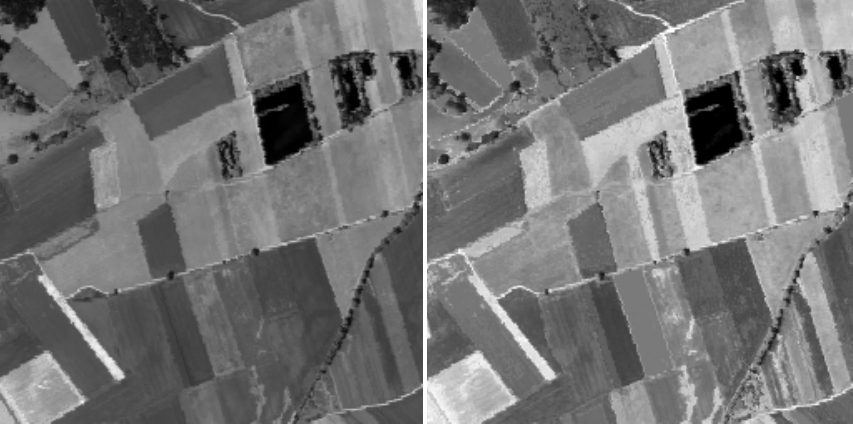
Figure 3: Input images used for experiment (a,b,c,e) and result